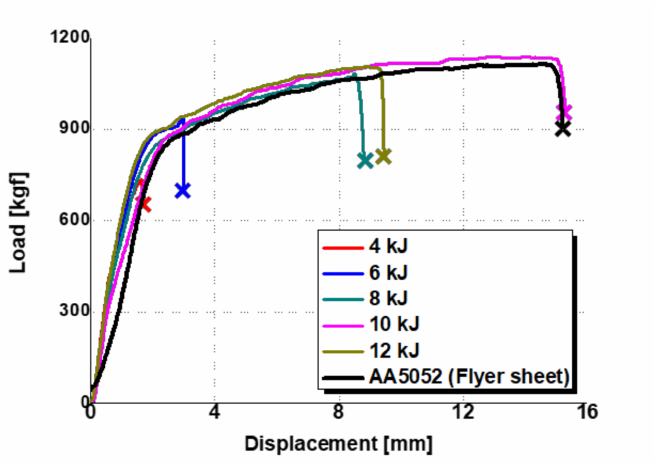
Figure 12. Load–displacement curve in a lap shear test with respect to the input